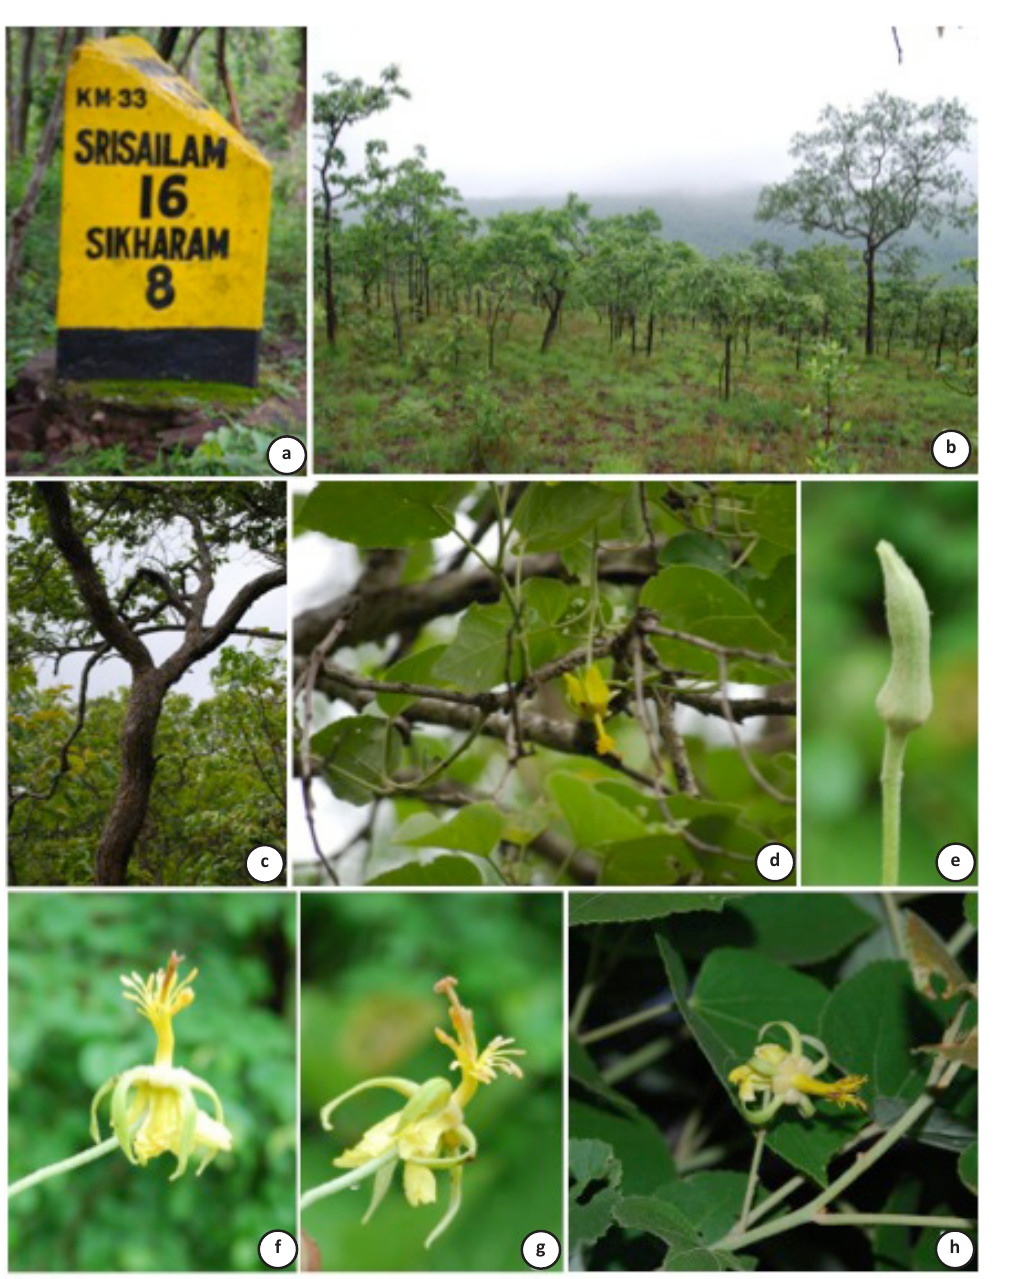
Image 1. Eriolaena lushingtonii : a- Landmark; b - Habitat appearance during June; c - Trunk; d - Flowering branch; e - Mature bud; f - Flower with unfolding stigmatic lobes; g - Flower with pentafid stigma in receptive state; h - Flower with filaments after feeding of anthers by an unidentified beetle. © Prof. A.J.